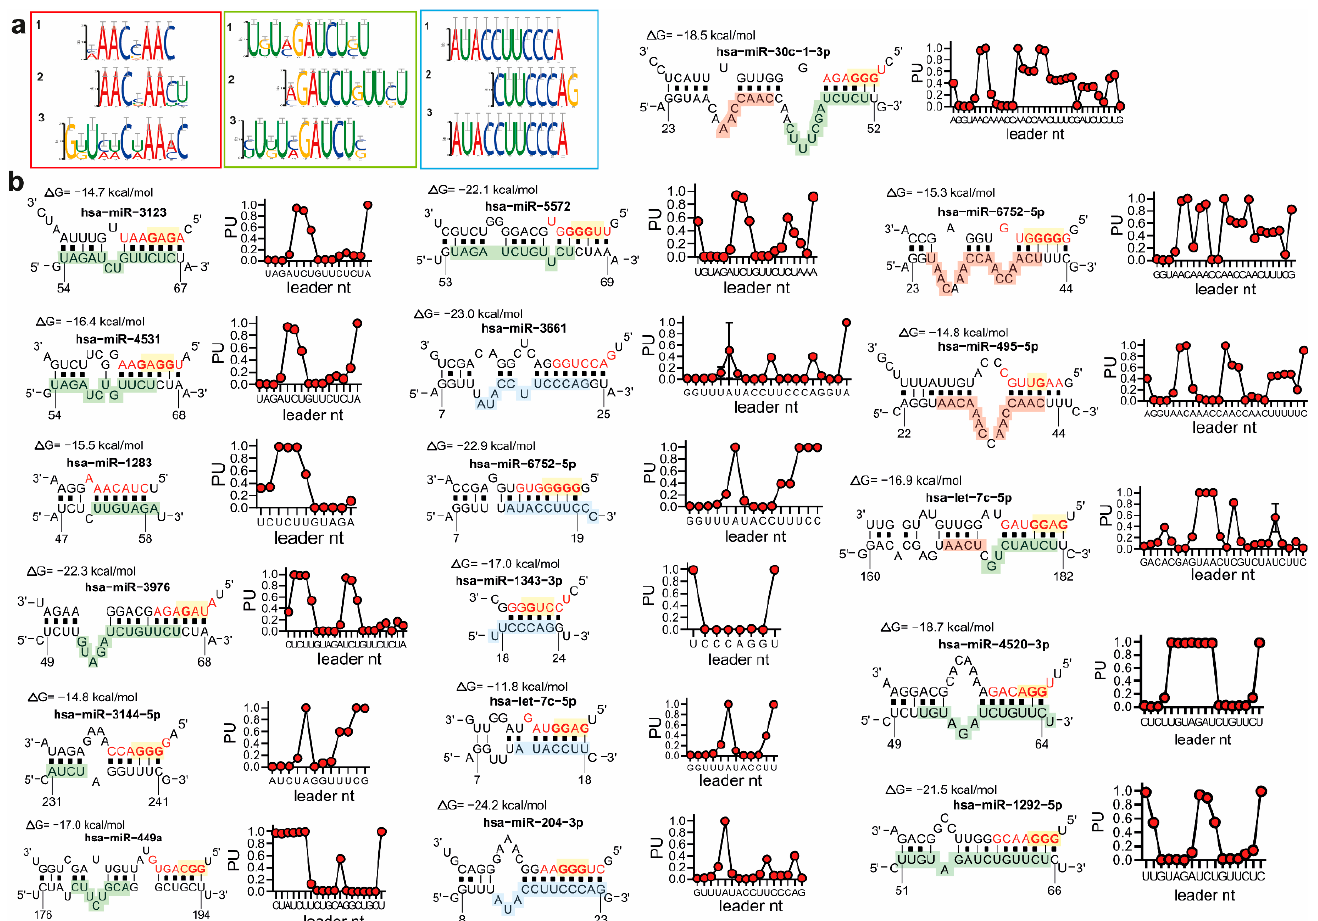
Figure 4. Detailed motifs identified at the SARS-CoV-2 5 ′ UTR leader sequence and thermodynamic evaluation of their interaction with miRNAs with a GGG motif in their seed. ( a ) Three leader motifs identified with RNAup (1), IntaRNA (2), and RNAplex (3). ( b ) Representation of miRNAs and their binding to the three motifs identified in the viral leader sequence. In yellow, the GGG motif. The three motifs are colored like in panel ( a ): AACnAAC (red), UnUnGAUCUnU (green), and AUACCUUCCCA motifs (light blue). Total free energy is represented as Δ G and expressed in kcal/mol. The thermodynamic, structural, and, therefore, reliable miRNA:RNA interactions analyzed using the StarMir algorithm are reported closed to each gmiRNA:RNA graphical representation. Data are represented as the probability of each nucleotide to be unpaired (PU), considering thermodynamic and structural features analyzed. The X axis of the graph reports the nucleotides (nt) of the viral leader sequence involved in the binding with miRNAs.